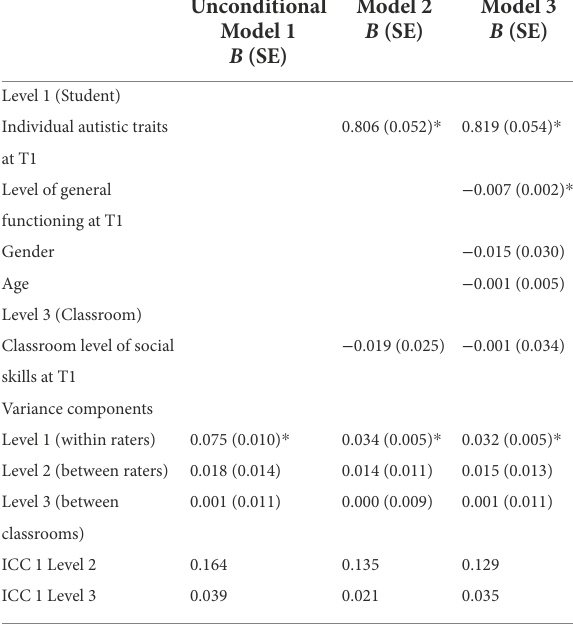
TABLE 3 Prediction of individual autistic traits at T2 from T1 classroom level of social skills.